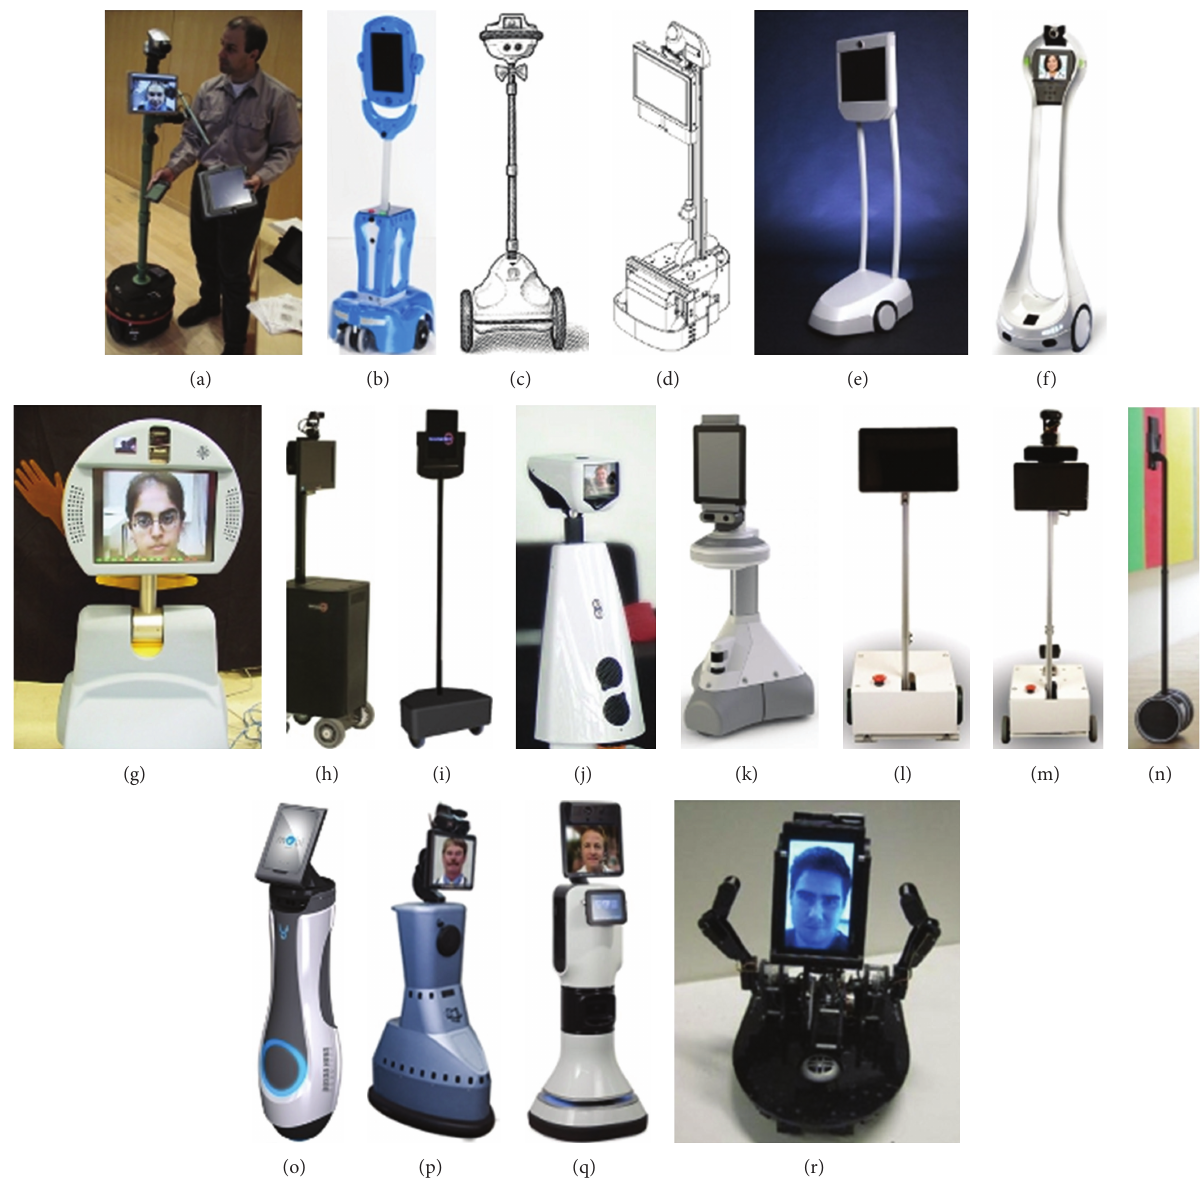
Figure 1: (a) PRoP, (b) Giraff, (c) QB, (d) Texai, (e) Beam, (f) VGo, (g) PEBBLES, (h) MantaroBot Classic, (i) MantaroBot TeleMe, (j) Jazz Connect, (k) iRobot Ava, (l) 9th Sense Helo, (m) 9th Sense Telo, (n) Double, (o) mObi, (p) RP-7, (q) RP-VITA, and (r)